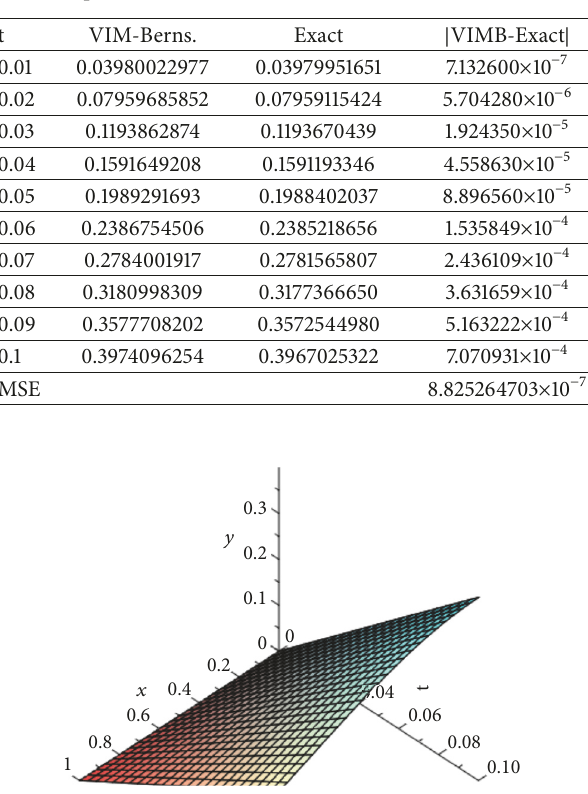
Table 2: The absolute and mean square errors using y 3 for Sine- Gordon equation when n=m=1 and 𝑥 = 0.1 .